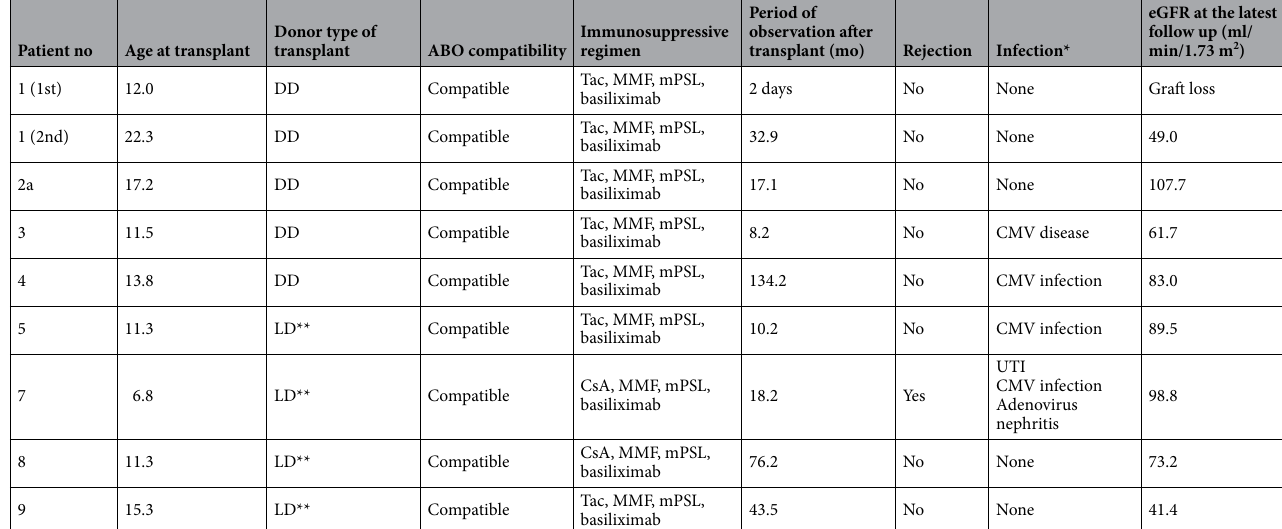
Table 2. Clinical characteristics of the transplanted patients. *Infection during the first year after kidney transplantation. **Patients 5, 7, 8, and 9 received preemptive kidney transplantation. DD deceased donor,